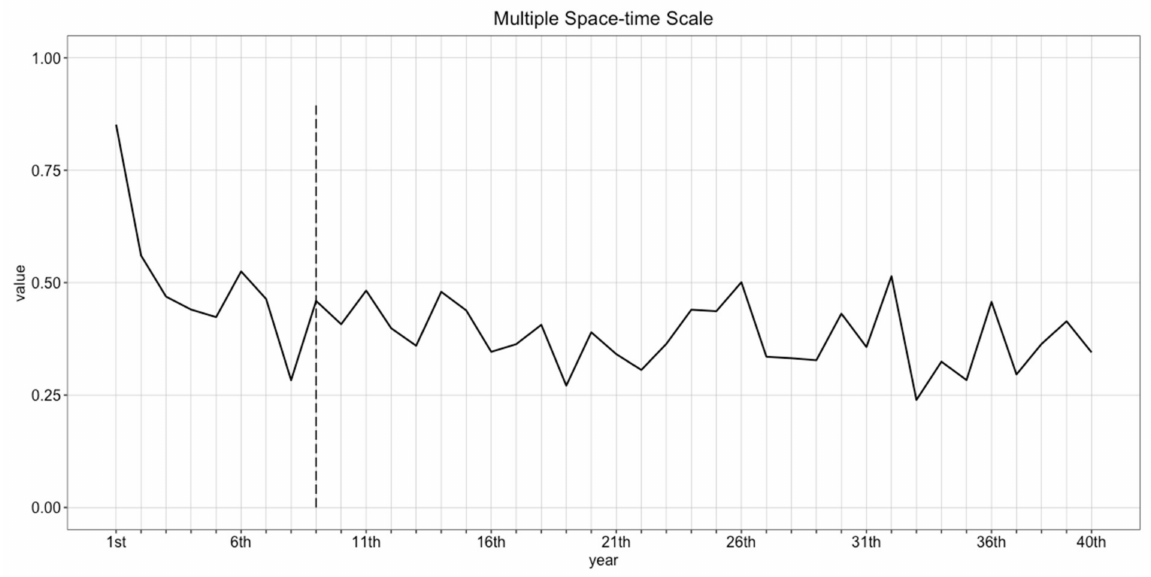
Figure 11. The average of the normalized CVs over simulation year. To avoid such issues, D at multiple space-time scales was also measured to determine the burn-in periods (Figure 12). As the required number of replicates was determined as 825, simulated outputs with 825 replicates were used. In each panel in Figure 12, vertical lines represent the burn-in period that have the minimum value of averages of d 1 ( p , t ) and d 2 ( p , t